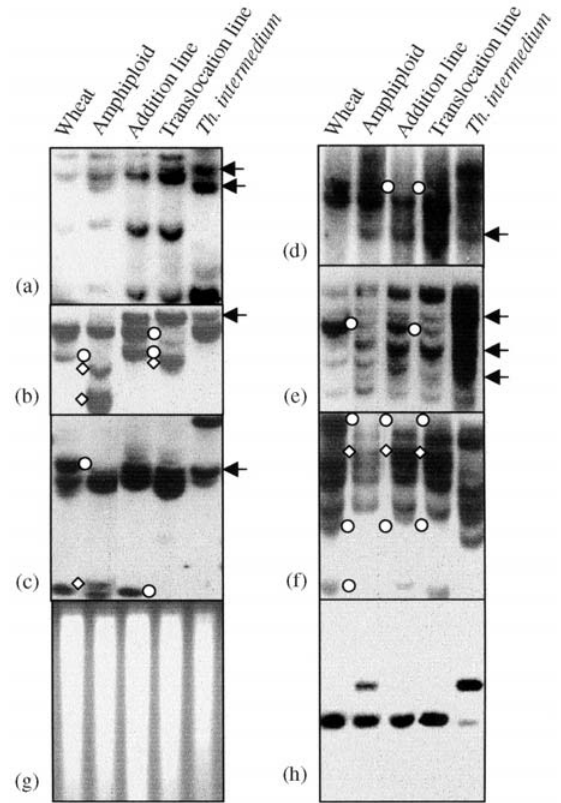
Figure 1 - Detection of the presence of Thinopyrum intermedium chromatin and genomic changes in octo-amphiploid (Zhong3), its derived addition line (TAI27) and translocation line (#32). (a) Hybridization of probe HP80 (mappedtohomoeologousgroup7)to Eco RI-digestedgenomicDNAsofcom- monwheat(lane1),Zhong3(lane2),TAI27(lane3),Line#32(lane4)and Th. intermedium (lane 5). The upper arrow denotes a Th. intermedium fragment present in all three lines (Zhong3, TAI27 and Line #32) but the wheat parent; the lower arrow indicates a Th. intermedium fragment present only in Zong3. (b) Hybridization of probe Psr160 (mapped to homoeologous group 7) to Eco RI-digested genomic DNAs of the same samples as above. The arrow de- notes a Th. intermedium fragment present only in TAI27 and line #32; the cir- cles and diamonds refer, respectively, to loss of wheat parental fragments and gainofnovelbandsinZhong3andLine#32.(c)HybridizationofprobePsr148 (mapped to homoeologous group 7) to Dra I-digested genomic DNAs of the same samples as above. The upper circle refers to loss of a wheat fragment from all three lines (Zhong3, TAI27 and Line #32); the lower circle refers to lossofawheatfragmentfromLine#32.Thediamondindicatesgainofanovel fragment in Zong3. The arrow denotes a Th. intermedium fragment present in TAI27 and Line #32. (d) Hybridization of probe CDO1164 (mapped to homo- eologous group 3) to Bam HI-digested genomic DNAs of the same samples as above.Thearrowdenotesa Th.intermedium fragmentpresentinallthreelines (Zong3, TAI27 and line #32); the circles refer to loss of a wheat parental frag- ment in TAI27 and Line #32. (e) Hybridization of probe Thg26 (a repeat iso- lated from genomic DNA of Th. intermedium ) to Eco RI-digested genomic DNAsofthesamesamplesasabove.Thearrowsdenote Th.intermedium frag-